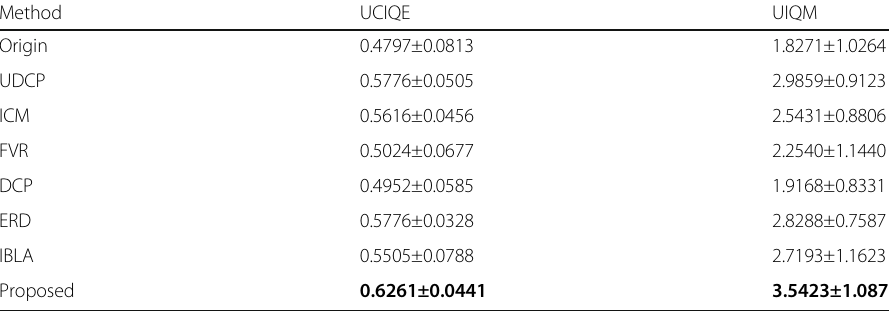
Table 3 Comparison of overall performance based on over 140 underwater image restoration results